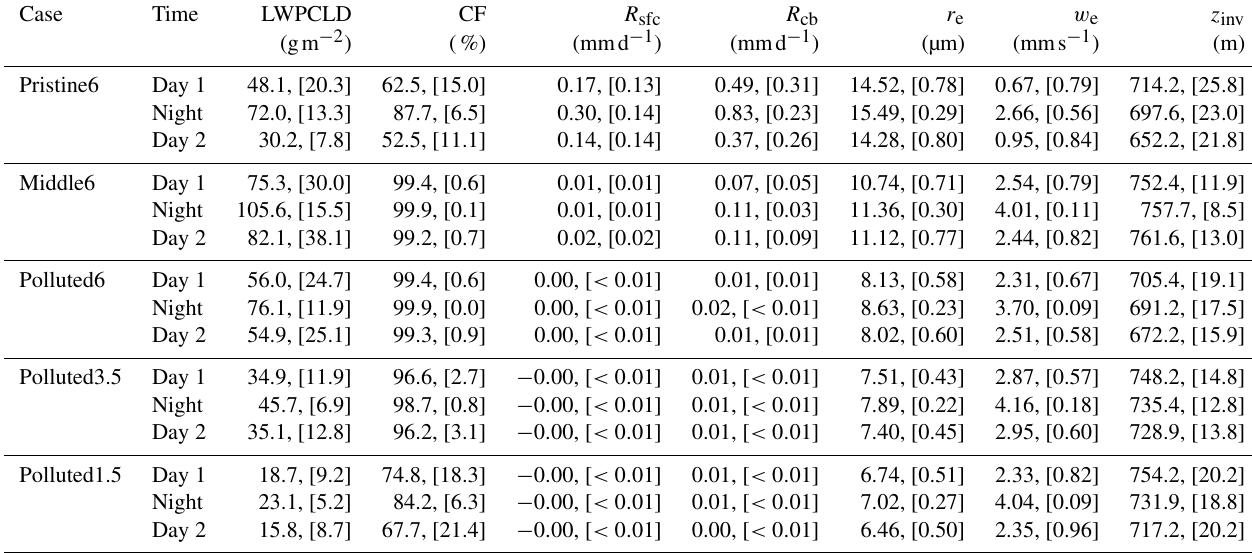
Table 2. Spatiotemporal averages from the baseline (Ctrl) simulations of the in-cloud LWPCLD, cloud fraction (CF), surface precipitation rate ( R sfc ), cloud-base precipitation rate ( R cb ), effective radius of cloud drops ( r e ), entrainment rate ( w e ), and inversion height ( z inv ) for the simulated cases. The first, second, and third values represent averages across Day 1, Night, and Day 2, respectively, with the standard deviations shown in square